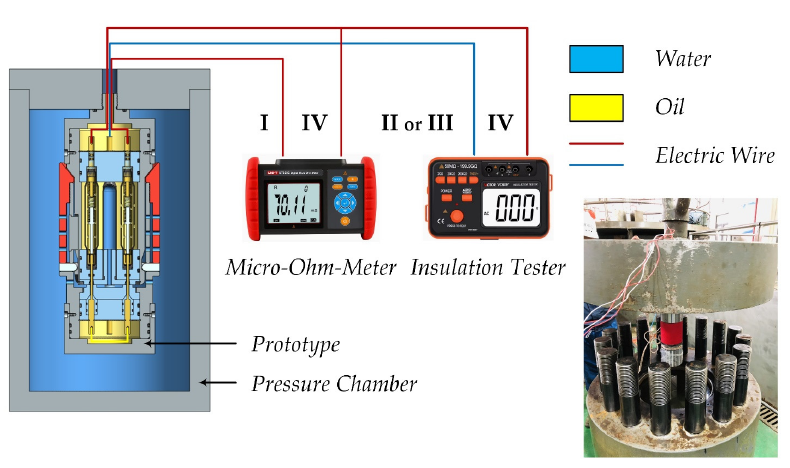
Figure 18. A schematic illustration of the prototype’s online test of electrical performance in pres- sure environment.